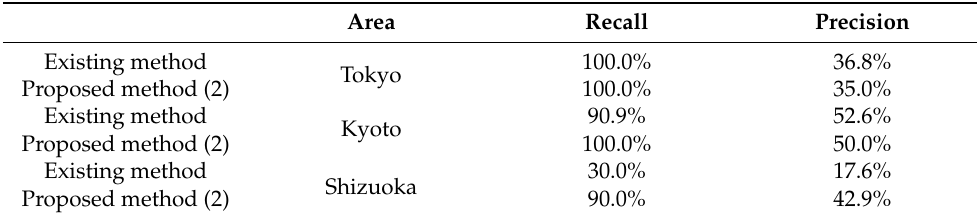
Table 4. Recall rate and precision rate between existing method and proposed method (2). Area